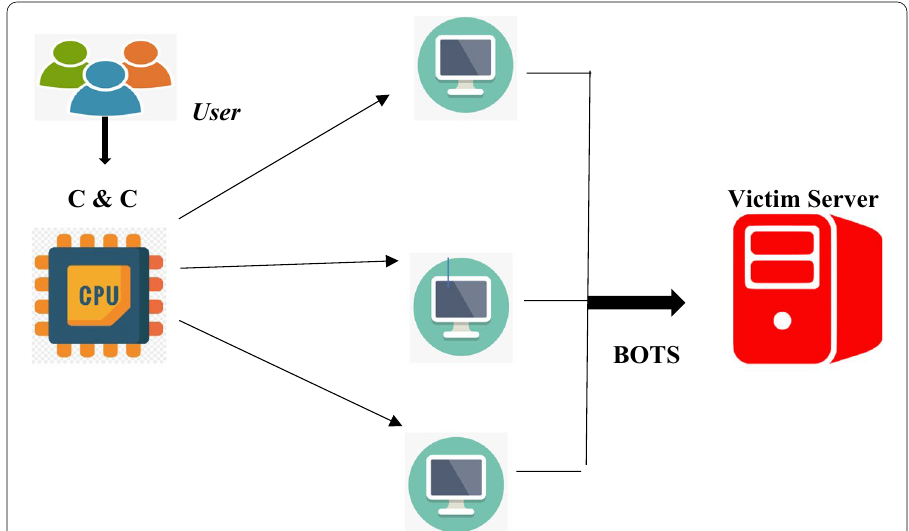
Fig.1 DDOS Attack Scenario on Victim